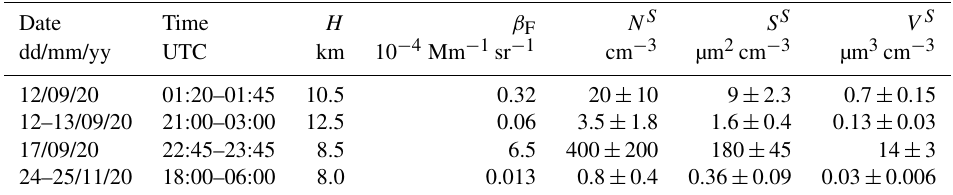
Table 2. Number N S , surface area S S and volume V S concentrations of smoke particles inside the ice cloud at height H estimated from fluorescence measurements by applying the conversion factors in Eq. (3) for four measurement sessions.